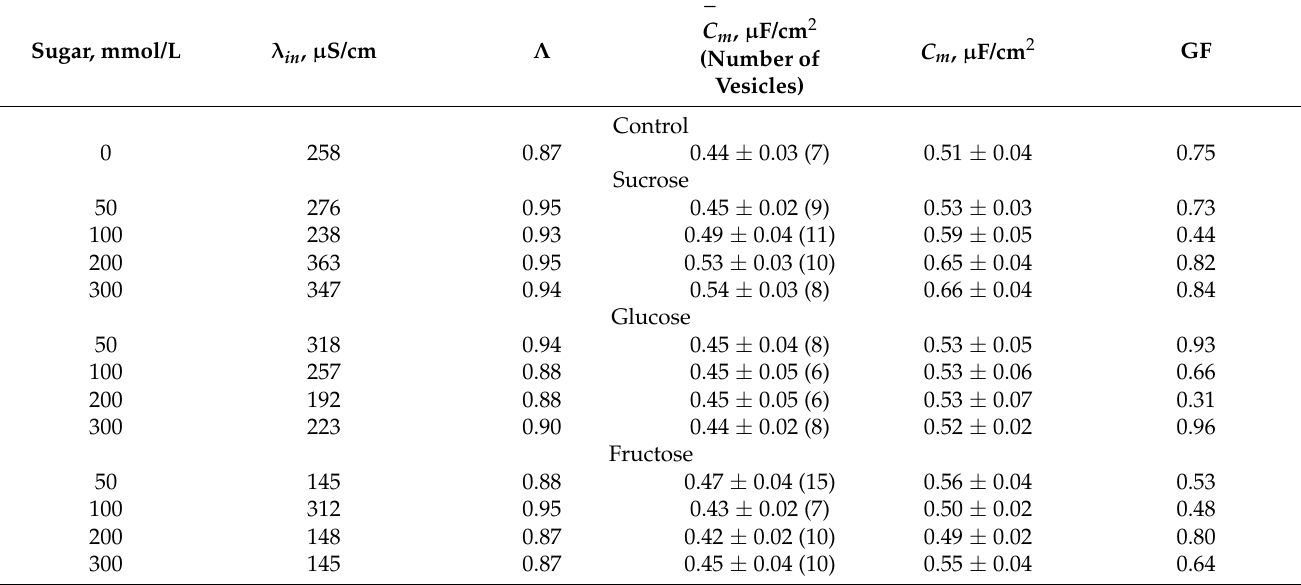
Table 1. Specific capacitance of POPC membranes in aqueous solutions containing different concentrations up to 300 mmol/L glucose, fructose or sucrose; data obtained from electrodeformation of GUVs; GF, goodness of fit. The errors in C m and C m are standard